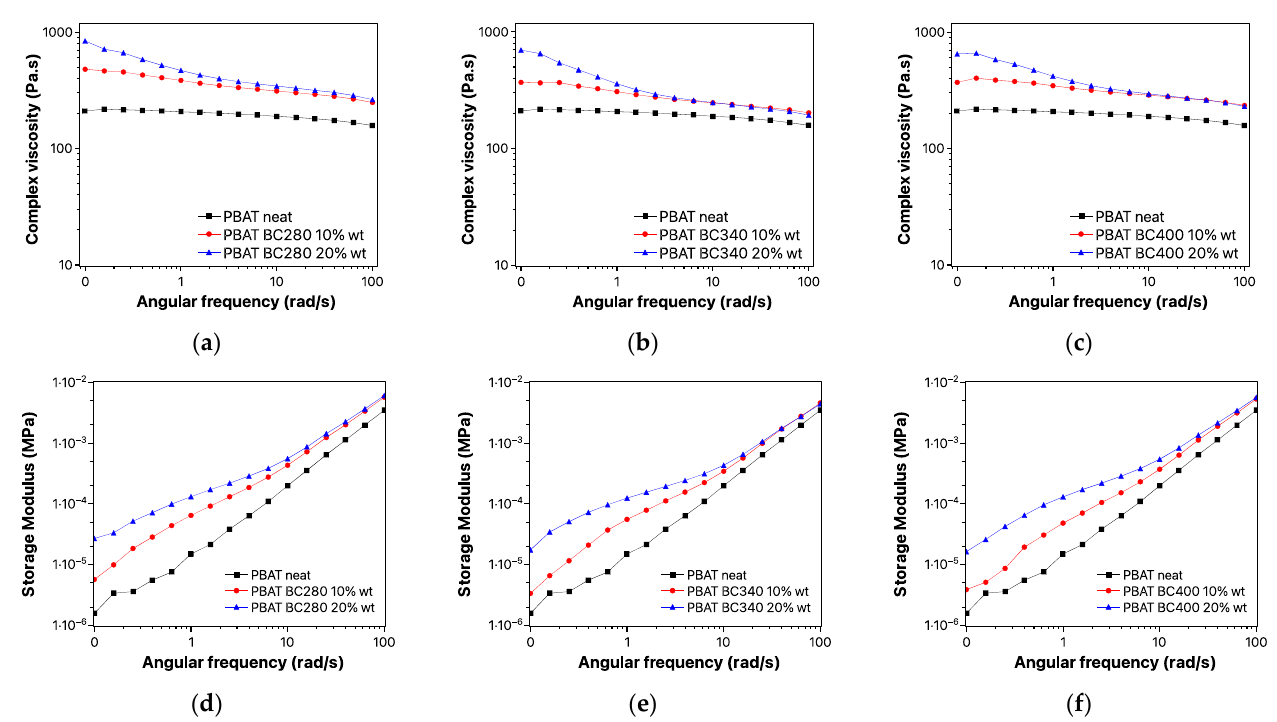
Figure 4. Rheological behavior of bio-composites: complex viscosity of ( a ) PBAT BC280, ( b ) PBAT BC340 and ( c ) PBAT BC400 and storage modulus of ( d ) PBAT BC280, ( e ) PBAT BC340 and ( f ) PBAT BC400 composites.